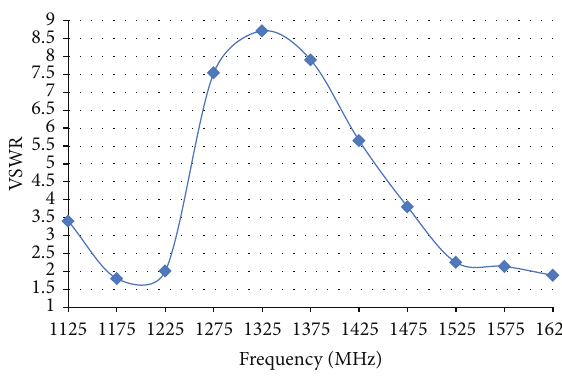
Figure 7: VSWR variation for the modified